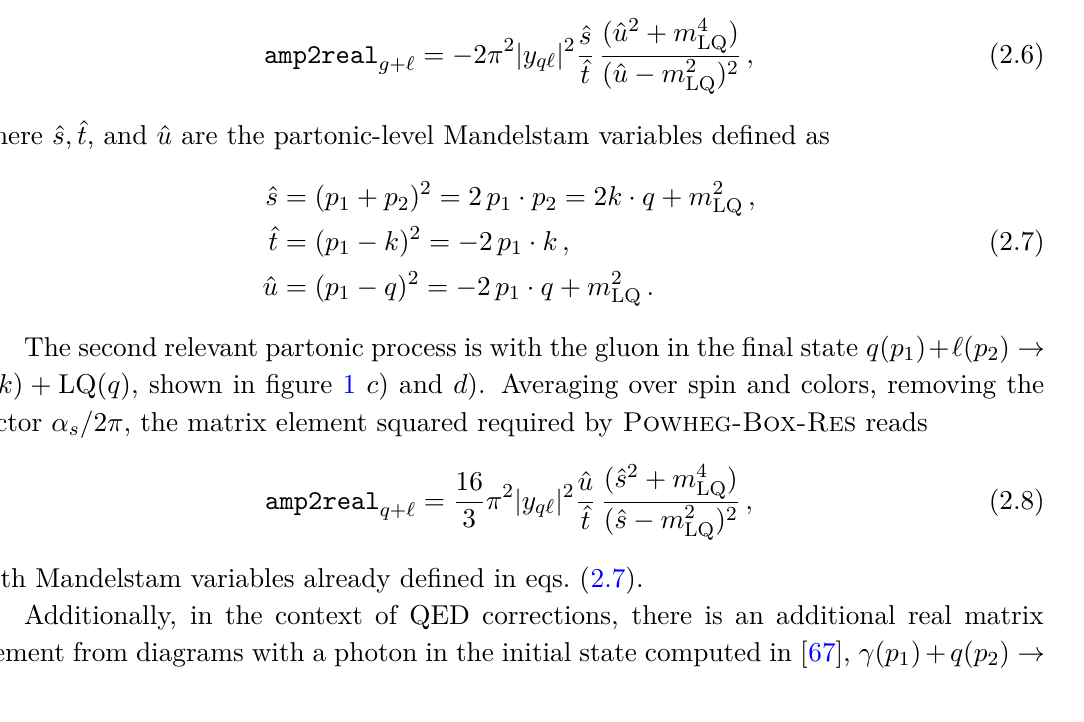
Figure 1 . Feynman diagrams for the resonant leptoquark production at NLO. Diagrams a ) and b ) are for g ( p )+ ‘ ( p ) → q ( k )+LQ( q ) contributing at O ( α 1 2 g ( k ) + LQ( q ) contributing at O ( α s ) . Diagrams e ) , f ) and g ) are for γ ( p 1 ) + q ( p 2 ) → ‘ ( k ) + LQ( q ) contributing at O ( α ) , but enhanced by the ratio of the photon PDF over the lepton PDF. Finally, diagrams h ) , i ) and j ) are the virtual corrections at O ( α